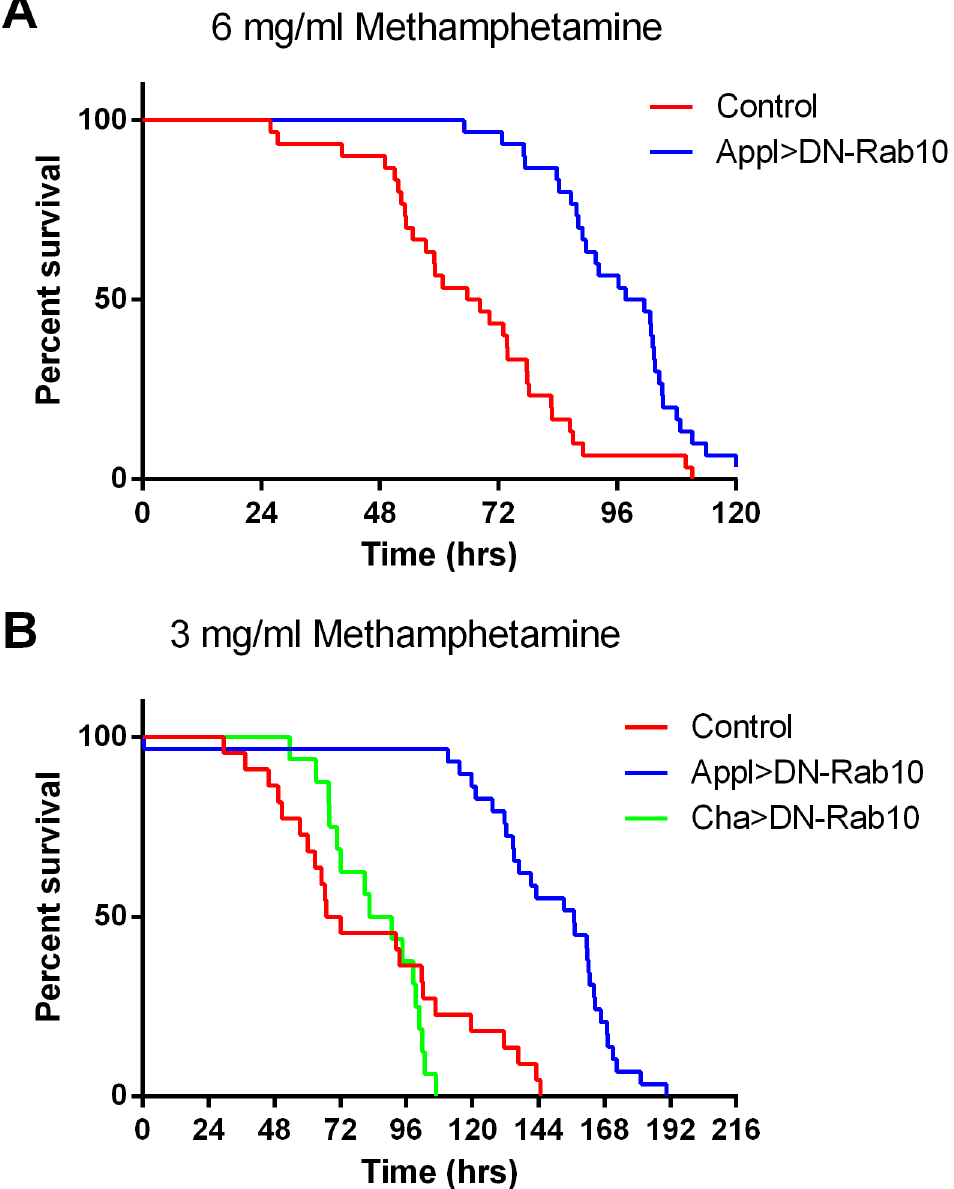
Fig 5. DN-Rab10 inhibits methamphetamine-induced mortality. Methamphetamine was added to the food at 3 or 6 mg/ml and the number of flies surviving over the next 8 days was determined. Death was recorded at the time activity was no longer detected. (A) The median survival time was 2.8 days for control (Appl-GAL4) flies fed 6 mg/ml methamphetamine and 4.1 days for flies expressing DN-Rab10 in all neurons (Appl > DN-Rab10). p = 0.0012 for comparison of the curves (Mantel-Cox log-rank test). The typical % survival over the same time period in flies not fed methamphetamine is greater than 90% (not shown). (B) The median survival time was 2.9 days for control flies (UAS-DN-Rab10), 6.5 days for flies expressing DN-Rab10 in all neurons (Appl > DN-Rab10) and 3.6 days for flies expressing DN-Rab10 in cholinergic neurons (Cha > DN-Rab10) and fed 3 mg/ml methamphetamine. P < 0.0001 for the comparison of the control and Appl > DN-Rab10 curves and p = 0.49 for the comparison of the control and Cha > DN-Rab10